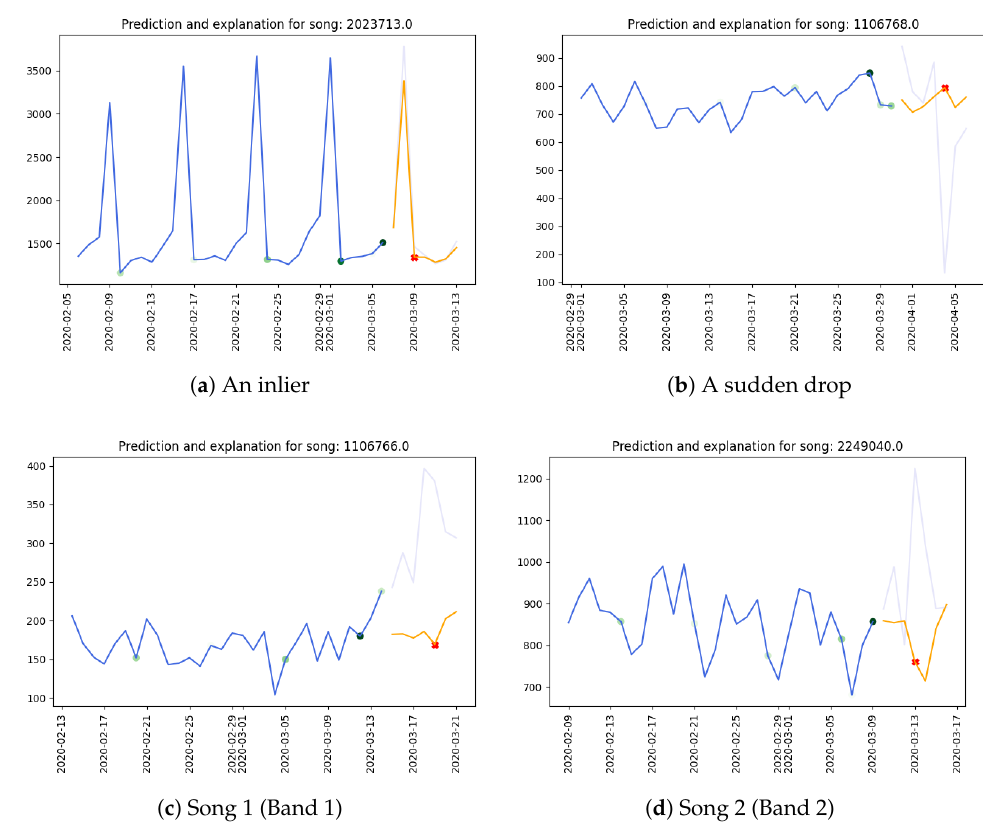
Figure 3. Static visualization for evaluation of 4 samples: One inlier Figure 3a and 3 songs with high outlier scores. The blue line (the context windows) and the gray line (the outlier windows) show the actual observations. The yellow line shows the prediction of the outlier window (Level 1 Explanation). In each visualization, a prediction is selected and marked with a red cross. The green markings within the context window show the most important features in the prediction and outlier score (Level 2 Explanation). The color indicates the